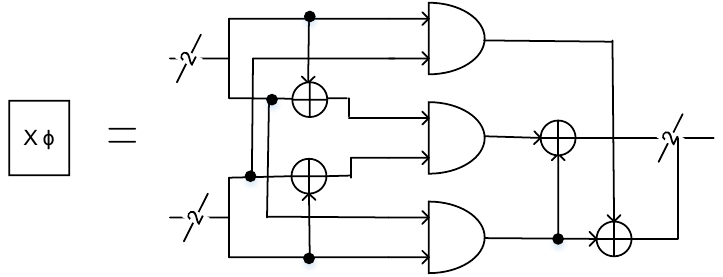
Figure 3. Squarer/Fermat inversion in the composite field GF (( 2 2 ) 2 ) . Fermat’s inversion and the squarer have a similar structure in GF (( 2 2 ) 2 ) and employ only a single XOR gate.